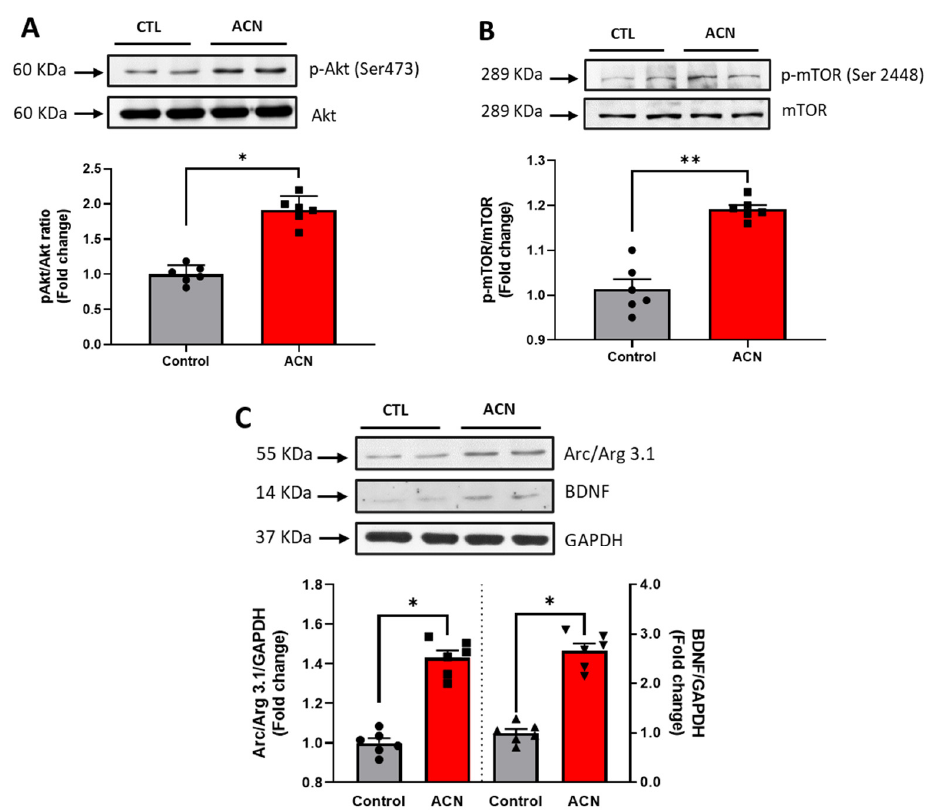
Figure 4. Immunoblotting analysis of proteins extracted from the hippocampus. Crude lysates (20–40 µ g protein) were immunoblotted with antibodies that specifically recognise ( A ) phospho-Akt Ser 473, total Akt; ( B ) phospho mTOR Ser 2448, total mTOR amd ( C ) Arc/Arg 3.1, BDNF and GAPDH. Results (phospho/total ratio for Akt Ser473, mTOR Ser 2448; protein/GAPDH ratio for Arc/Arg3.1 and BDNF) are presented as means ± SEM ( n = 6). Band intensities were determined by densitometric analysis using Fiji Image J. ** p < 0.01; * p < 0.05: indicate significant differences versus control. CTL = control; ACN =